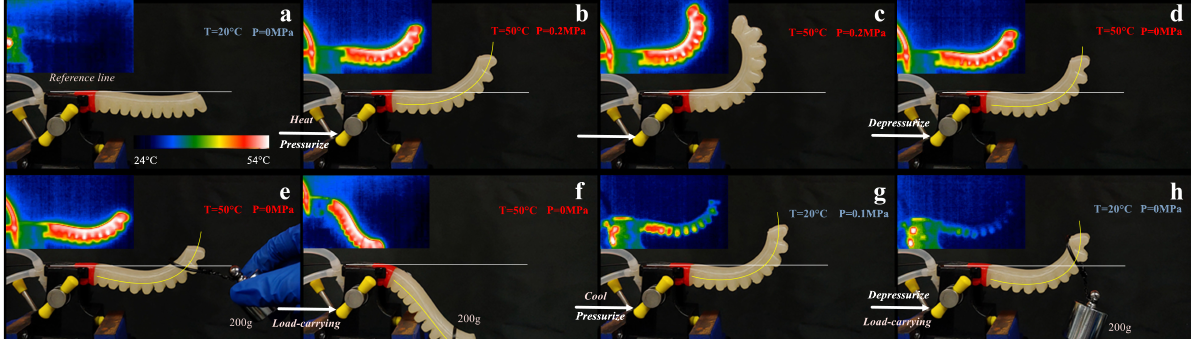
Figure 6. The demonstration of actuation and bending of the actuator. ( a ) Initial state of the actuator (T = 20 ◦ C, P = 0 MPa). ( b ) The actuator’s pressure and temperature increased (T = 50 ◦ C, P = 0.2 MPa) to achieve bending. The white line denotes the reference, and the yellow line represents the bending profile of the actuator. ( c ) The actuation time is increased to achieve a higher bending angle. ( d ) The actuator’s pressure is decreased while maintaining the temperature (T = 50 ◦ C, P = 0 MPa) to revert the actuator to its initial position. ( e ) Demonstration of loading (200 g) in the actuator (T = 50 ◦ C, P = 0 MPa). ( f ) Demonstration of bending in the opposite direction due to the high load suspended in the actuator. ( g ) High-stiffness state of the actuator is achieved by unloading the actuator and reducing its input temperature and pressure (T = 20 ◦ C, P = 0.1 MPa) to achieve a high-stiffness state in the actuator. ( h ) Demonstration of the load-carrying capacity (200 g) of the actuator when the pressure is reduced (T = 20 ◦ C, P = 0 MPa). The thermography images of ( a – h ) is shown in the inset